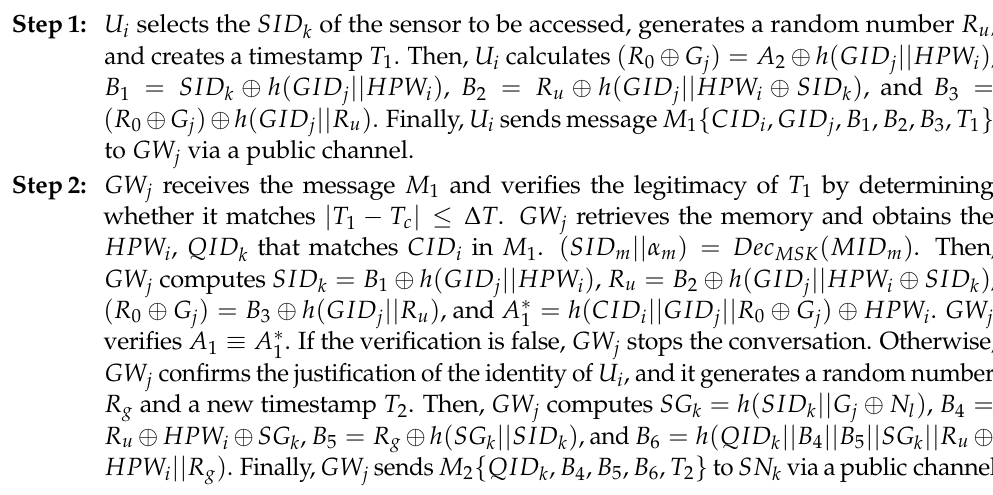
Figure 3. Authentication and key agreement phase of Chen et al.’s